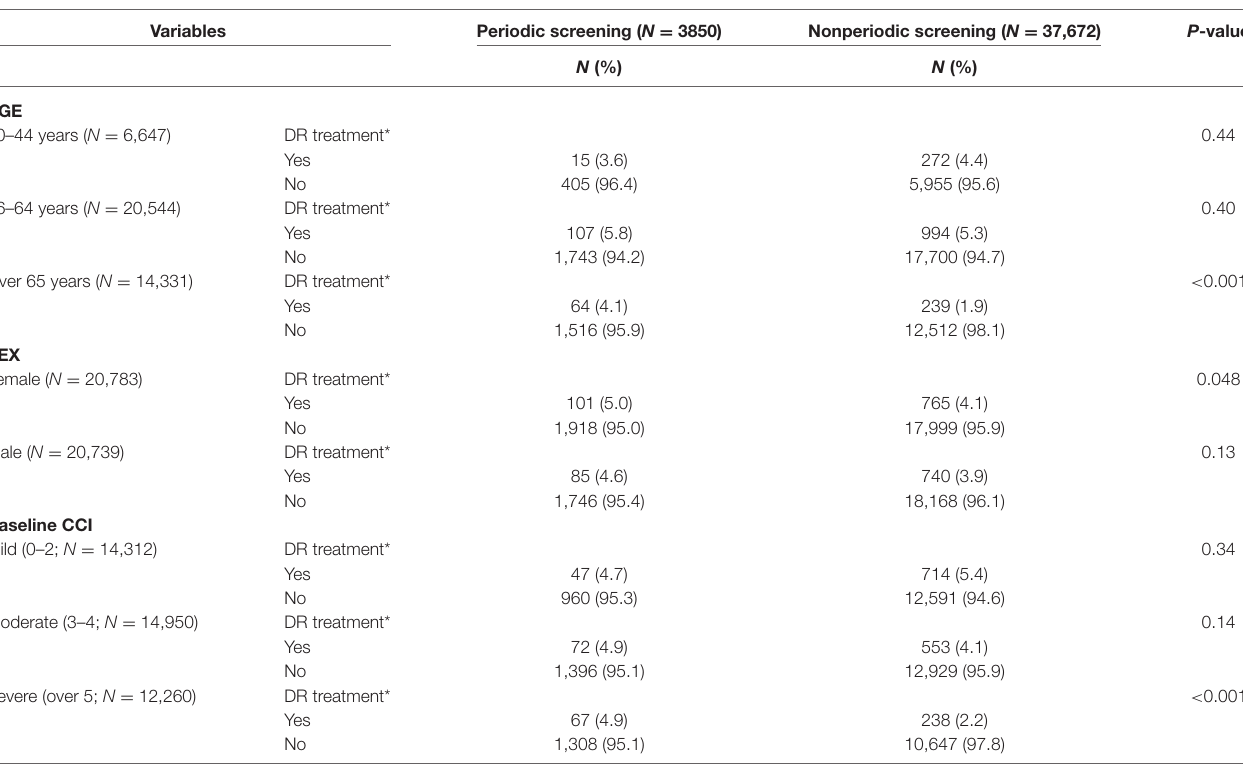
TABLE 2 | Stratified